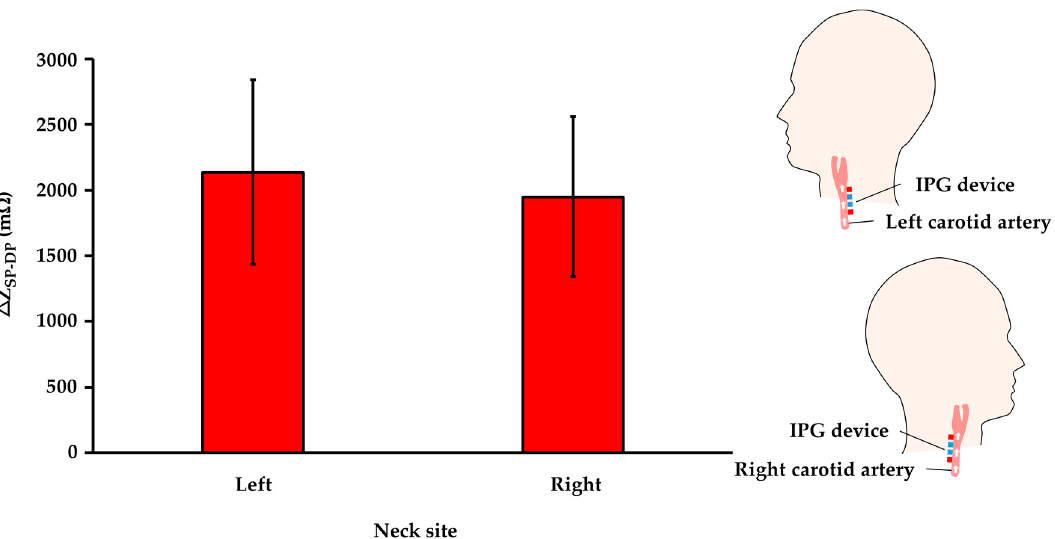
Figure 9. The comparison results of IPG measurement resolution between carotid arteries in the left and right sides (n =